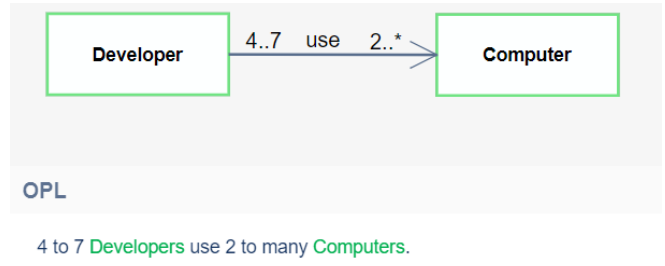
Figure 11. source and destination link cardinality example. Figure 11. Source and destination link cardinality example.